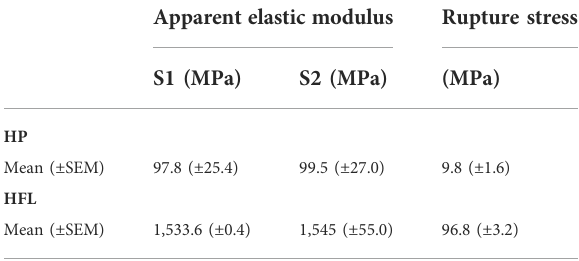
TABLE 2 Mechanical outcomes after tensile tests. S1: Speed 1 (0.25 mm/s), S2: Speed 2 (0.5 mm/s), HFL: human fascia lata ( N = 11 donors × 5 strips from each donor leading to n = 55 specimens analyzed for each speed), HP: human periosteum ( N = 6 donors